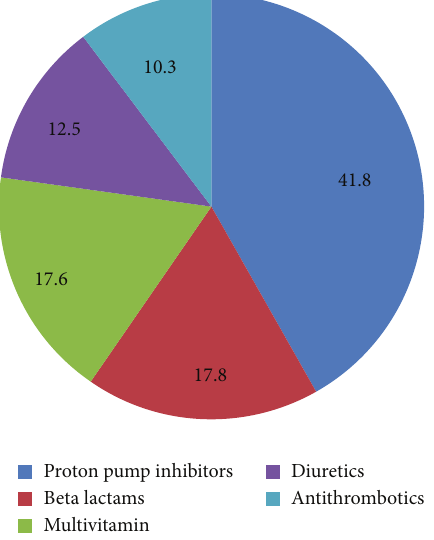
Figure 3: Percentage of the drugs used as